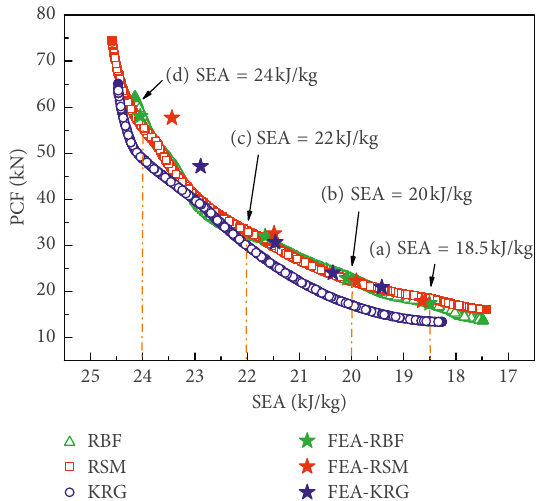
Figure 10: Pareto fronts by different surrogate